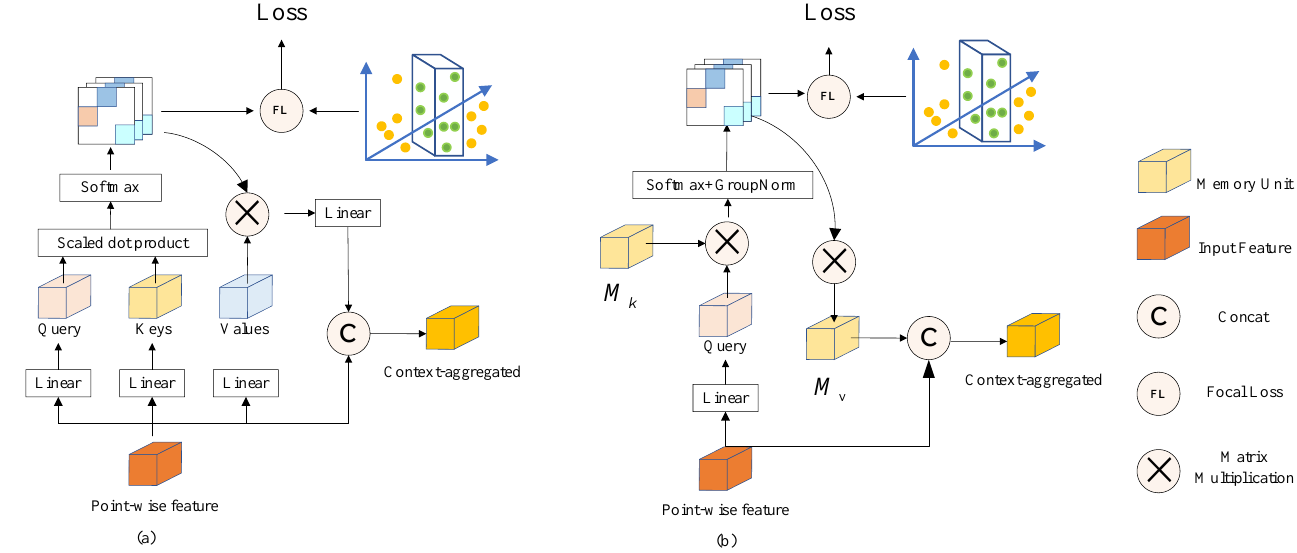
Figure 3. PEA module. ( a ) Point self-attention module; ( b ) point external attention module.